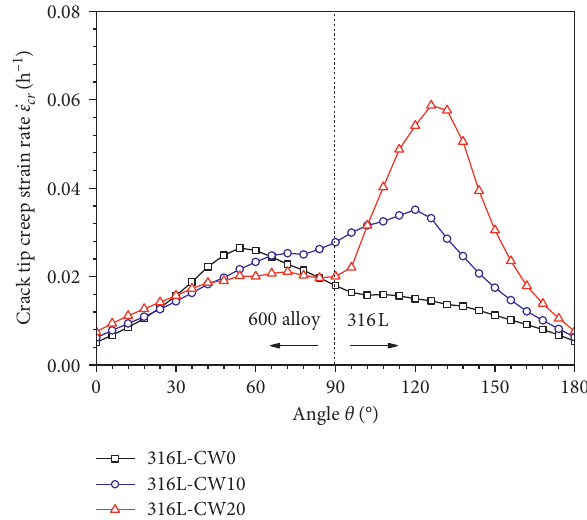
Figure 9: Effect of cold working of the heat-affected zone on the creep rate.